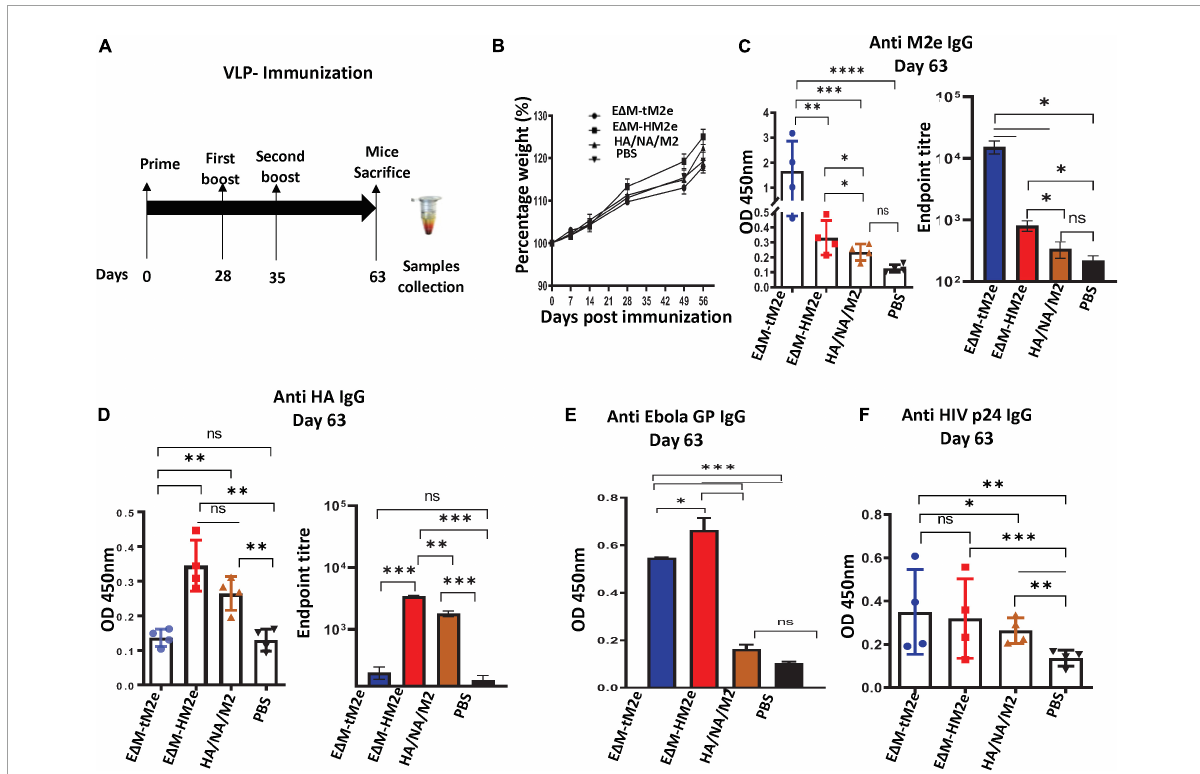
FIGURE2 The anti- M2e and anti-HA antibodies were induced by E (cid:49) M-tM2e- or E (cid:49) M-HM2e -VLPs in Balb/c mice (A) Schematic of the E (cid:49) M-tM2e, E (cid:49) M-HA M2e, or HA/NA/M2-VLP immunization protocol used in this study ( n = 4/5 mice per group). (B) Mice body weights were monitored weekly, in which 100% body weight was set at day 0. (C) The levels of anti-M2e, Left panel: OD 450 nm; Right panel: Endpoint titer. (D) Anti-HA M2e, Left panel: OD 450 nm; Right panel: Endpoint titer. (E) Anti-Ebola GP. (F) Anti-HIV P24. IgG-specific antibodies were measured by the ELISA method. Statistical significance was determined using an unpaired t -test, and significant p -values were represented with asterisks ∗ ≤ 0.05, ∗∗ ≤ 0.01, ∗∗∗ ≤ 0.001, and ∗∗∗∗ ≤ 0.0001. No significance (ns) was not